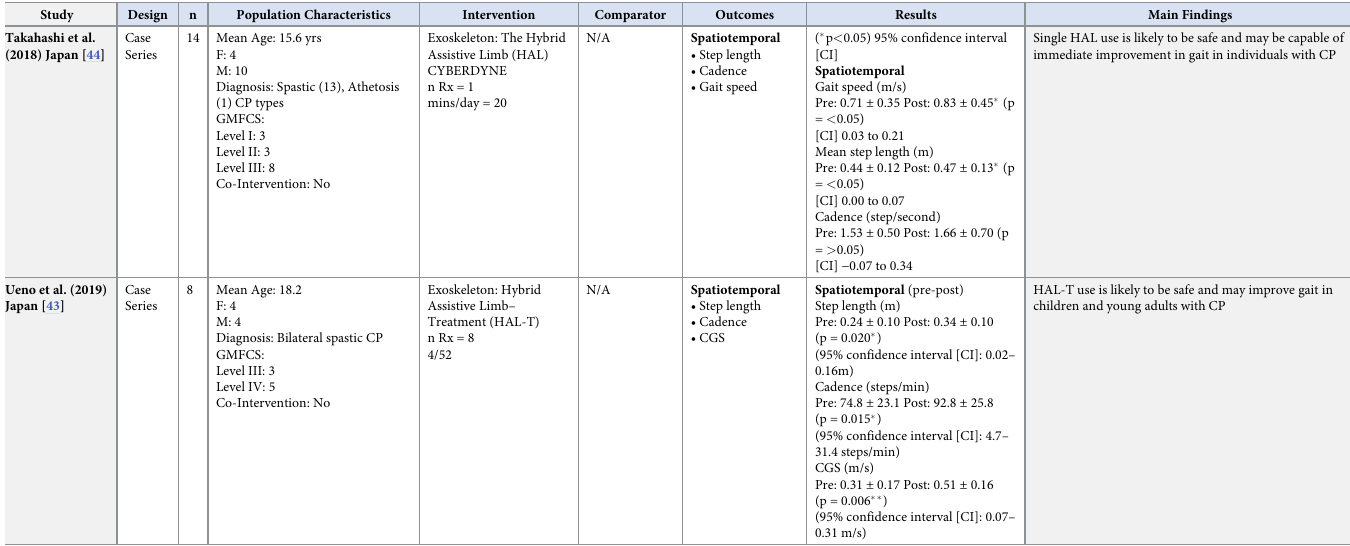
KEY: GMFCS = Gross Motor Function Classification System, CGS = comfortable gait speed, 10MWT = ten metre walk test, 6MWT = six minute walk test, ROM = range of motion, PROM = Passive range of motion, LL = lower limb, EMG = electromyography, iEMG = integrated electromyography, SCALE = Selective Control Assessment of Lower Extremity, PCI = Physiological Cost Index, GDI = Gait Deviation Index, GPS = Gait Profile Score, GMFM-88 = Gross Motor Function Measure– 88 Items, IC = initial contact, CGS = comfortable gait speed, n = number of, Rx = treatment, CP = cerebral palsy, M = male, F = female, P1 = patient one, P2 = patient two, P3 = patient three, P4 = patient four, R = right, L = left, MWS = maximum walking speed, SWS = self-selected walking speed, N/A = not applicable � = results are statistically significant (p = � 0.05)